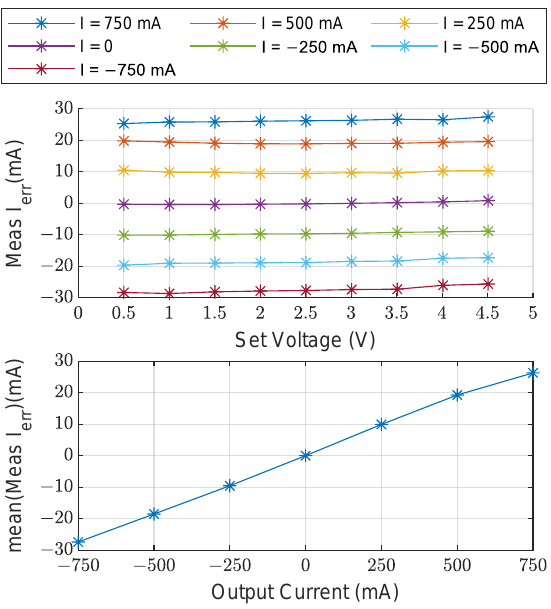
Figure 8. Characterization of the current measurement system error with different cell current values. Error as a function of the cell voltage set for different output current ( top ); mean current measurement error as a function of the output current ( bottom